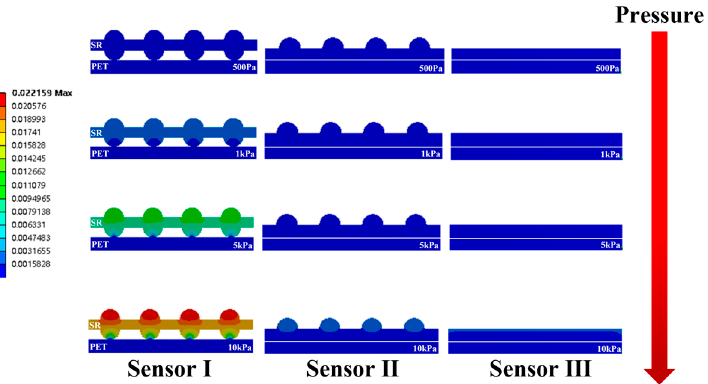
Figure 6. Finite element diagram of sensor I, sensor II, and sensor III under pressures of 0.5 Pa, 1 kPa, 5 kPa, and 10 kPa.